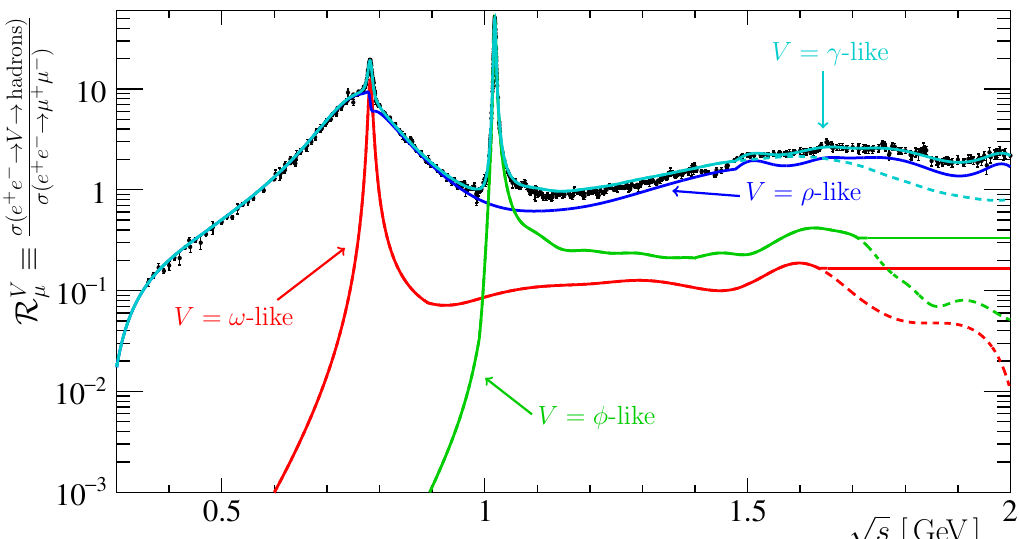
Figure 2 . Decomposition of e + e (cid:0) hadrons, which is of course (cid:13) -like, into ( (cid:26) -like) ( u (cid:22) u ! ( ! -like) ( u (cid:22) u + d (cid:22) d ) = p 2, and ( (cid:30) -like) s (cid:22) s contributions. See appendix B for detailed discussion on the derivation of these curves and on the meaning of the dashed